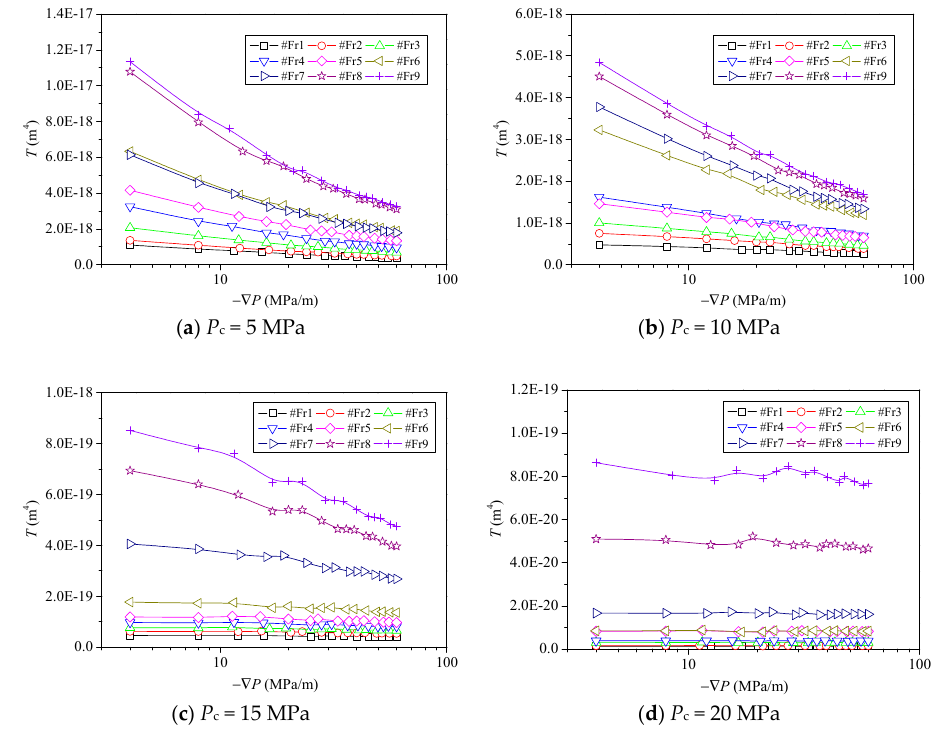
Figure 10. Relationships between pressure gradient and the transmissivity T .